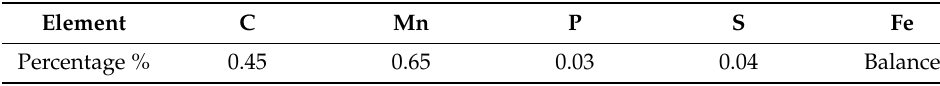
Table 1. Chemical content of AISI 1045 steel alloy [1].